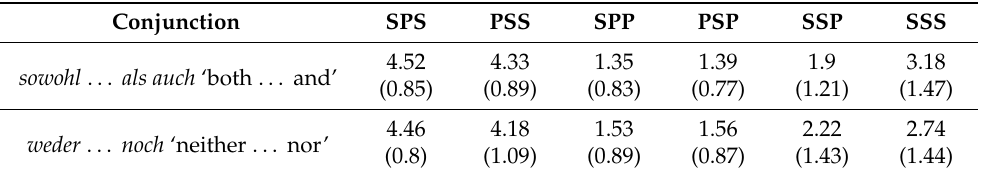
Table 2. Mean non-transformed acceptability ratings (SDs in parentheses) per condition for both conjunctions, Experiment 1 (S = singular, P = plural).